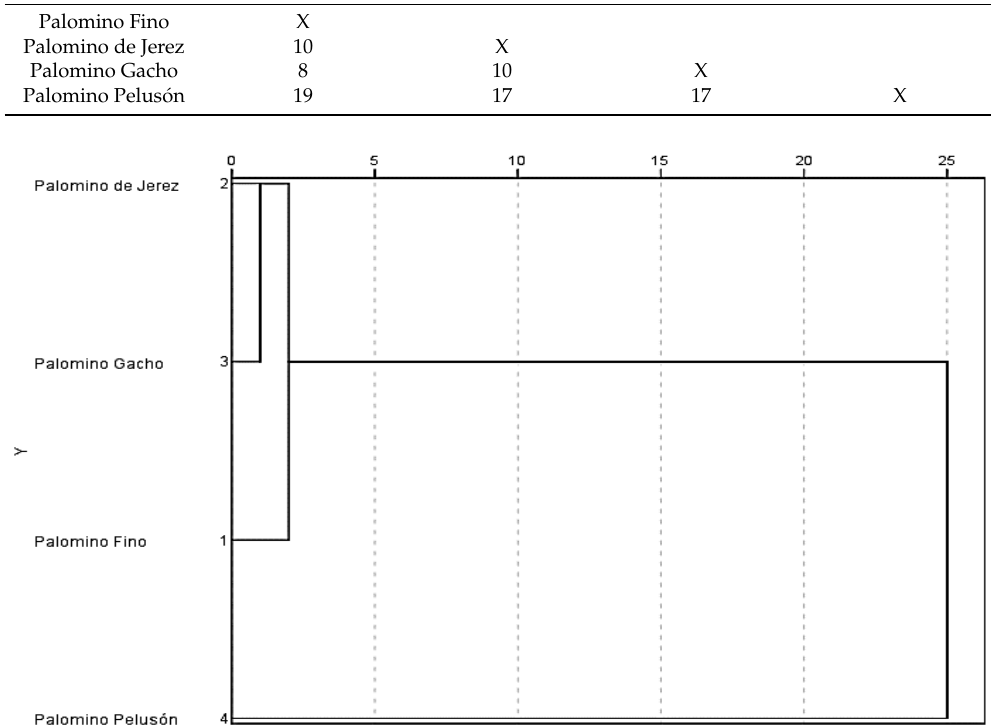
Figure 1. Dendrogram representing the di ff erences among the di ff erent variants studied based on ampelographic characterization employing an average link between groups and re-scaled distance cluster combination.